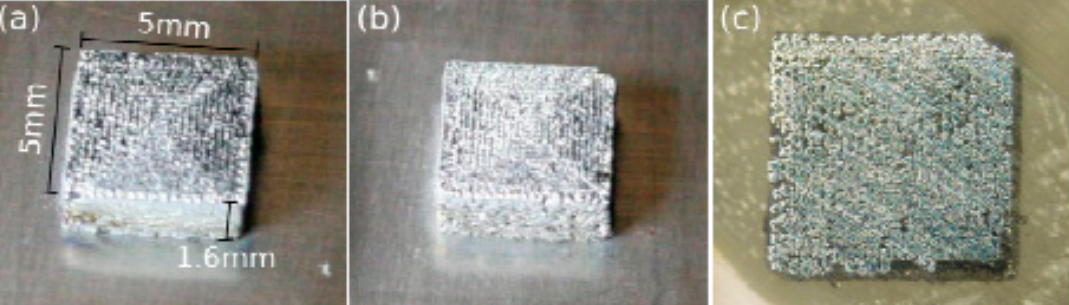
Figure 15. ( a , b ) The fs laser 3D printed tungsten cube with fs laser viewed from different angles; ( c ) polished top surface (Adapted from reference [7]).